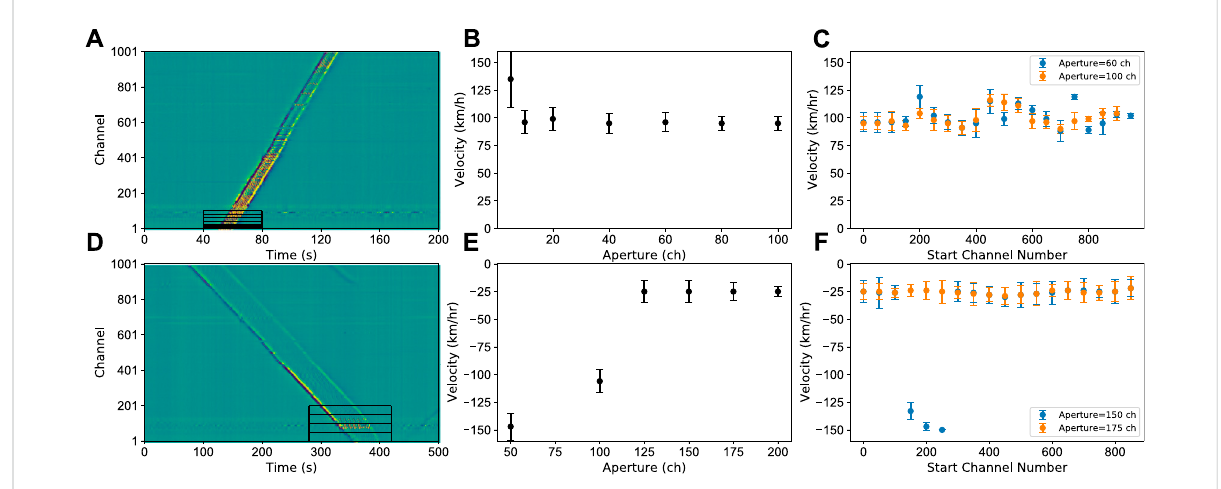
FIGURE 10 Array aperture test for an EMU train and conventional train. (A) EMU train case with different apertures/channels sliced as denoted by black squares; (B) Detection results with different apertures as shown in (A) ; (C) Detection results of moving arrays with 60 and 100-channel aperture; (D – F) Same as (A – C) , but for a conventional train case.